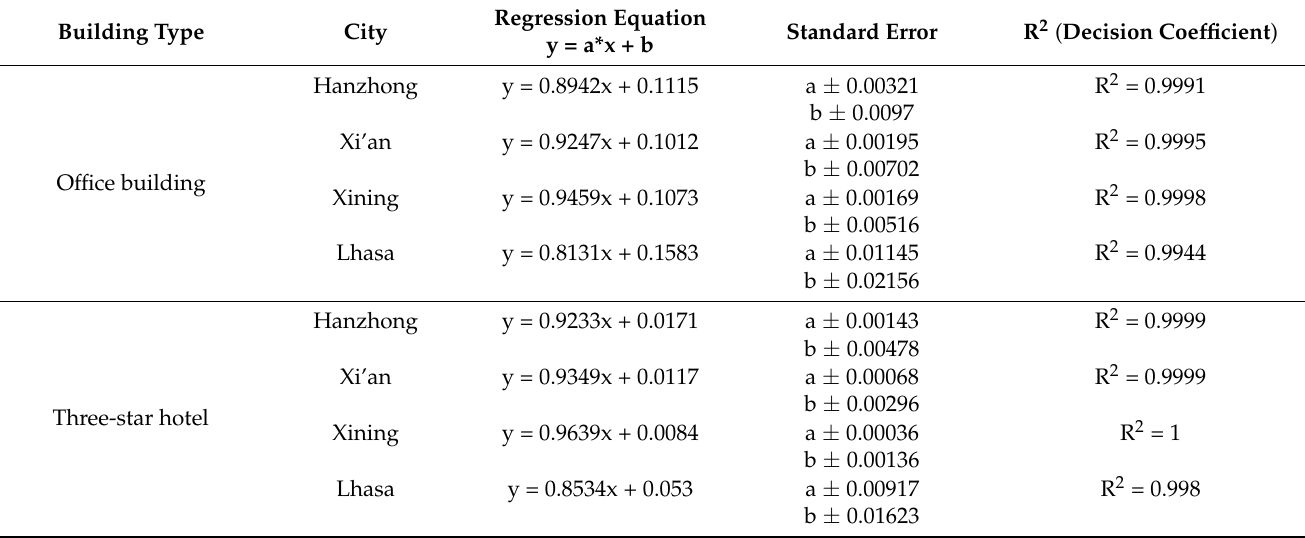
Table A3. The mathematical model established when Q is the independent variable.